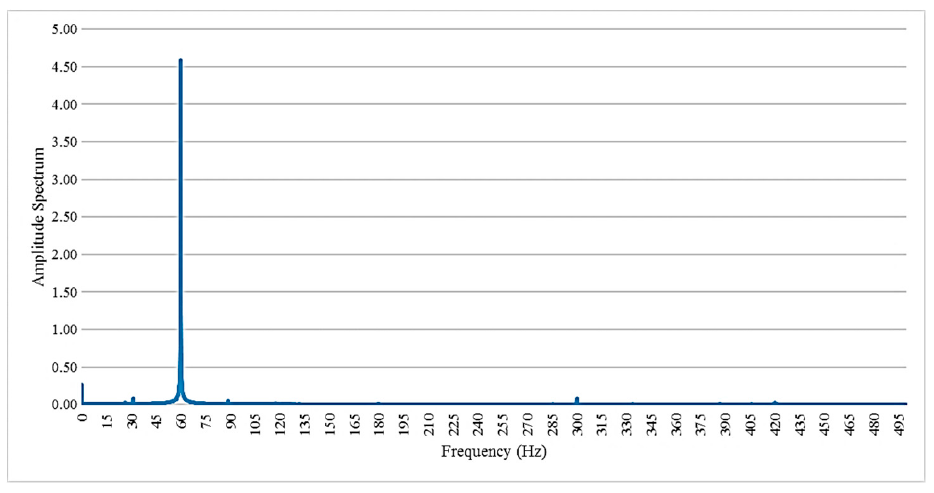
Figure 3. Frequency transformation of a healthy motor condition.